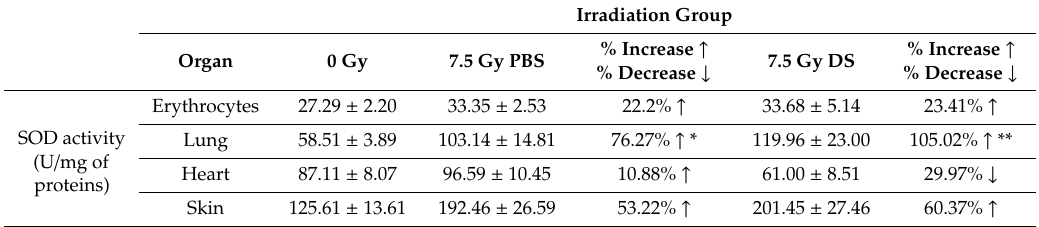
Table 1. SOD activity in erythrocytes, lung, heart and skin of mice irradiated by PBS or DS proton beams in the plateau phase of the Bragg